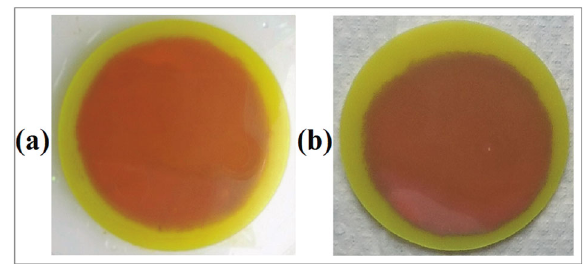
Fig. 1 Leveling effect. a Picture of the corroded CCL disc when the cell was leveled. b Picture of the corroded CCL disc when the cell was off level by ~1 degree.